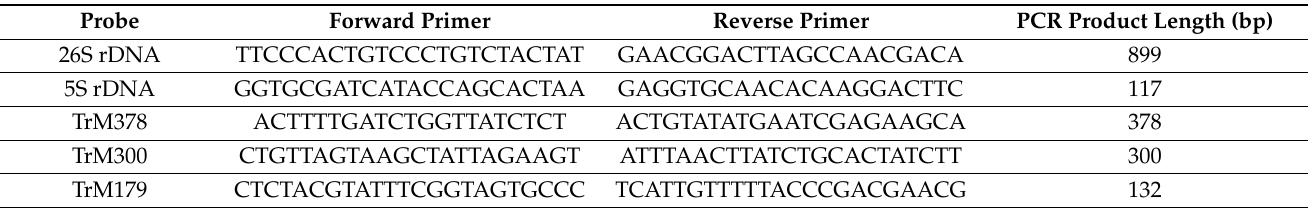
Table 3. Primer sequences used for amplification of DNA for FISH